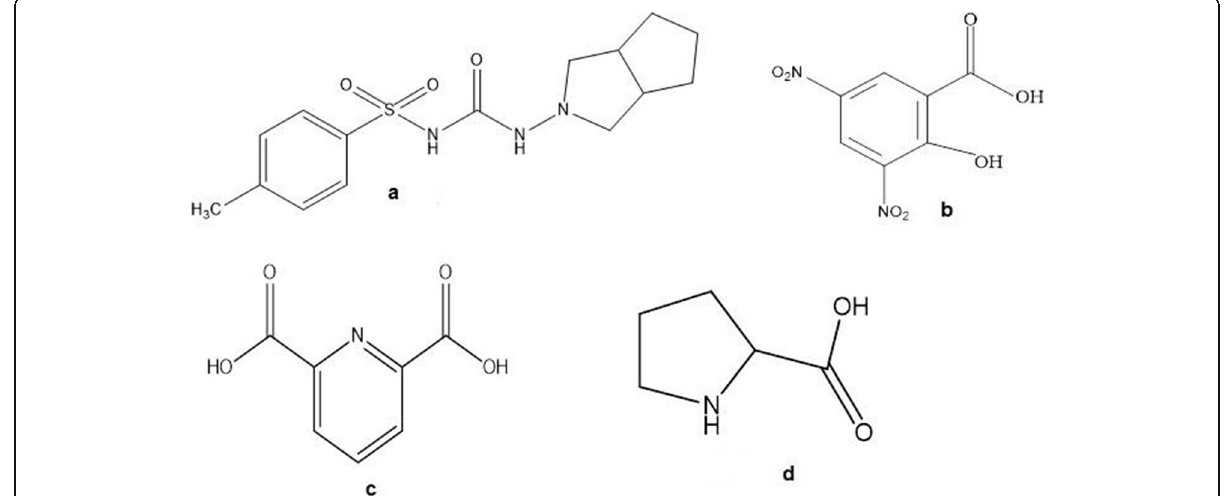
Fig. 1 Chemical structures of a GLZ, b DNS, c PDA, and d